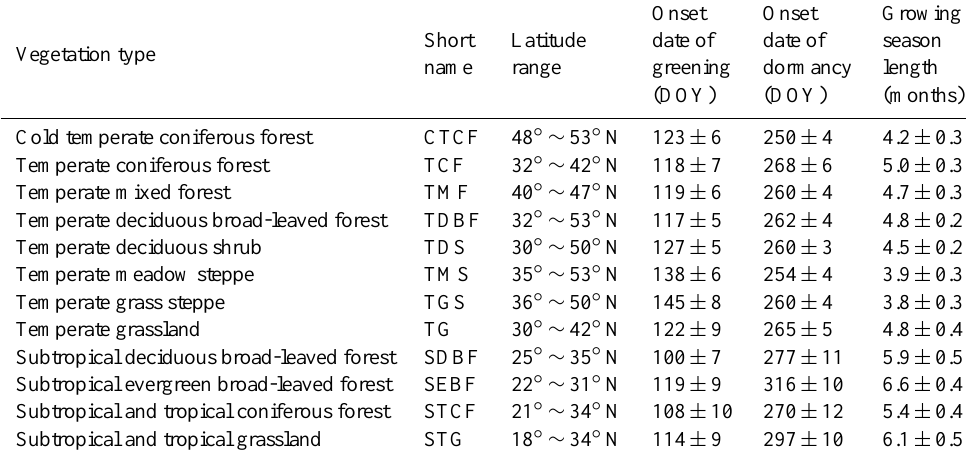
Table 1. Statistics for the twelve vegetation types that are distributed along the north–south transect of eastern China (NSTEC). Phenology events (onset dates of greening and dormancy) are derived from their respective seasonal dynamic curves of NDVI (Yu et al., 2010).